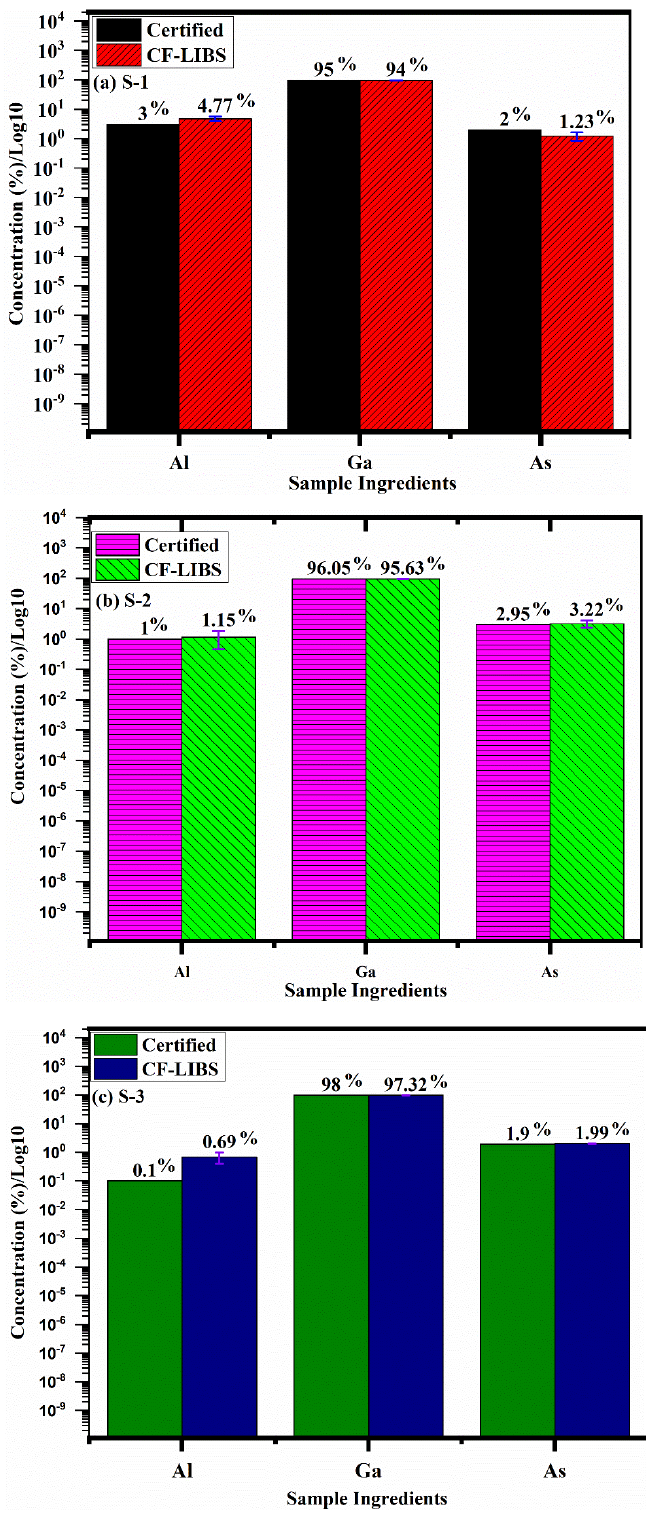
Figure 7. A histogram across elements versus concentration with varying wt.% of Al, Ga and As for both certified and CF ‒ LIBS. ( a ‒ c ) bar chart shows the comparison of concentration calculated by the CF-LIBS technique with that of the certified in the three samples specifically S ‒ 1, S ‒ 2, and S ‒